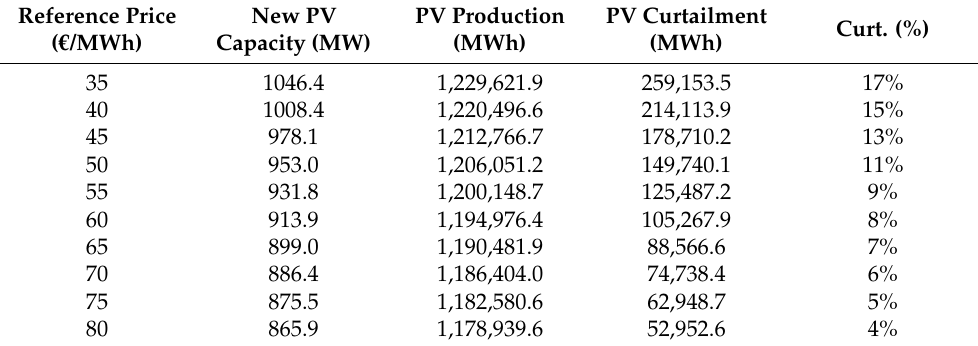
Table 2. Results for the second